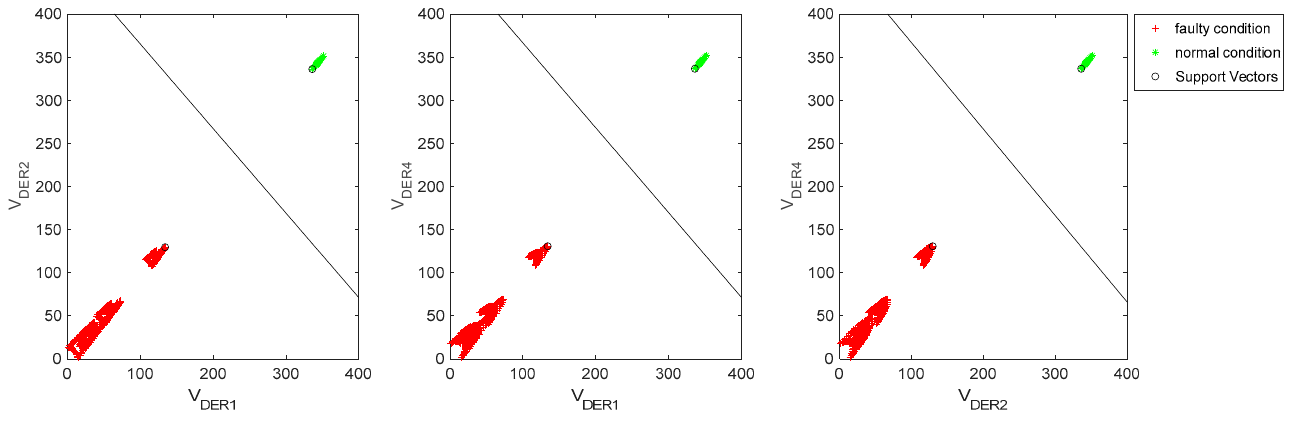
Figure 6. Fault detection based on rms voltages of DER 1, 2, and 4.